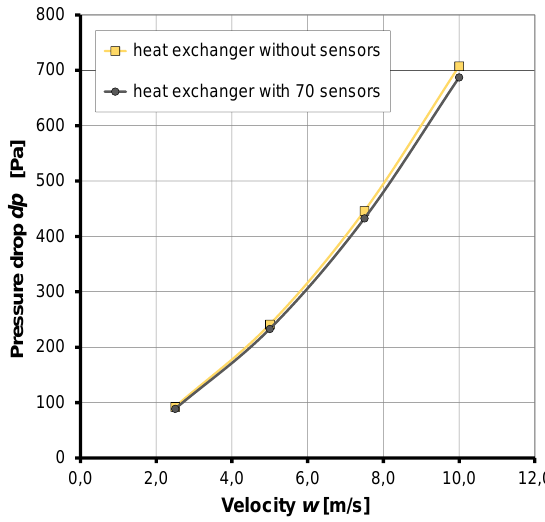
Fig. 8. Pressure drop of the entire heat exchanger models (porous zones) with and without the sensors. CFD numerical simulations for the whole exchanger model were performed under the same conditions as